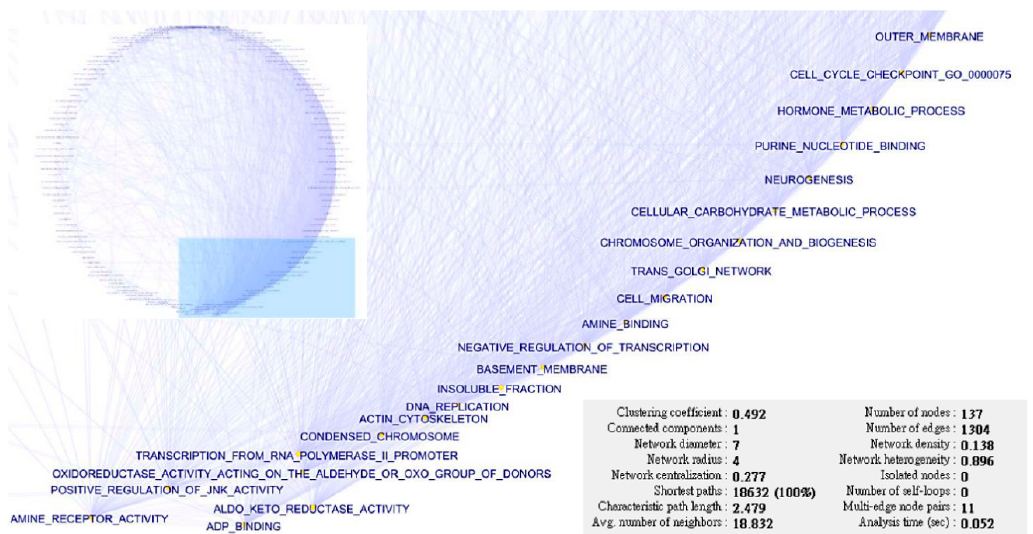
Figure 7. Interaction network of SC pathogenesis. The figure shows the interactions among the deregulated GO functions constructed from the elements identified in the exploratory factor analysis (EFA). The largest network consisting of 137 elements was extracted and displayed by the degree sorted circular layout. The deregulated functions with largest numbers were magnified to show the details. The network statistics are displayed in the bottom right part of the figure.